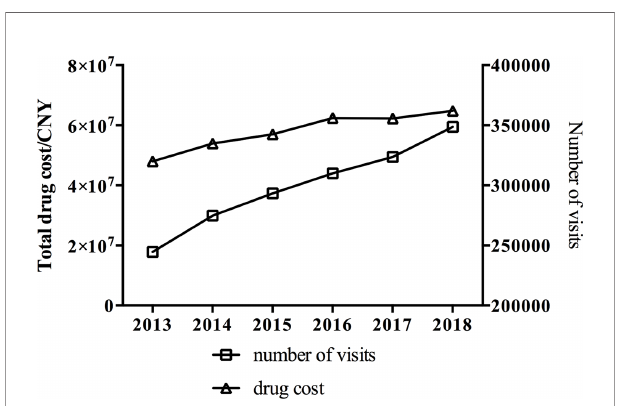
FIGURE 1 | Trends in visits and cost of antidepressants in 79 hospitals located in six major cities in China from 2013